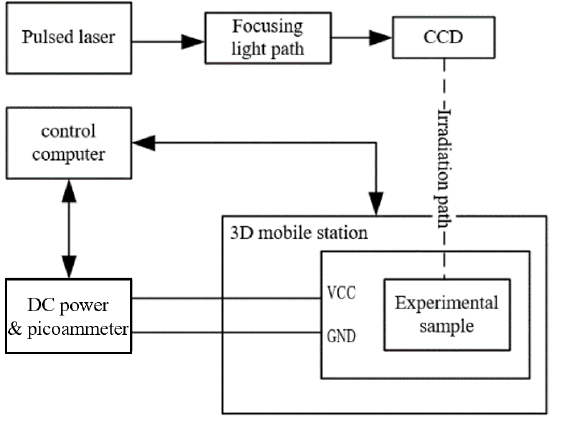
Figure 3. Schematic block diagram of pulsed laser irradiation test